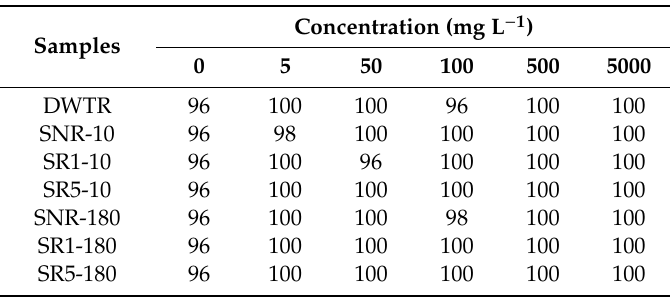
Table 3. Survival rate (%) of D. magna exposed to DWTR and sediments amended with and without DWTR in an acute